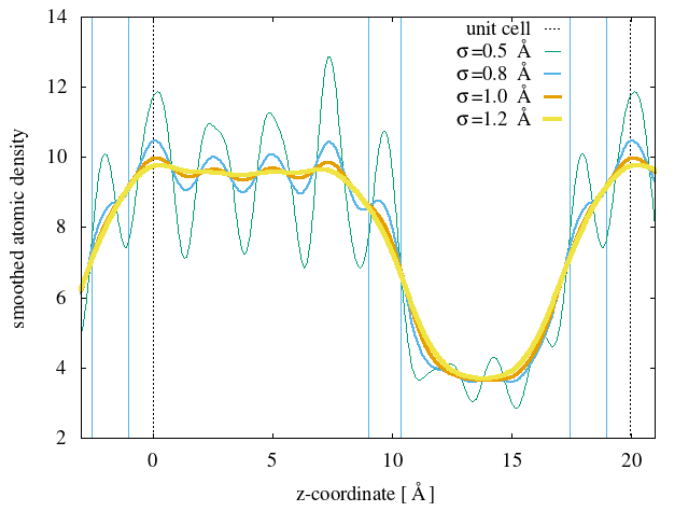
Figure 2. Planar average atomic density along the z direction (perpendicular to lamella surfaces) for the model shown in Figure 1. The various curves have been obtained by making different choices for the width σ for the Gaussian function representing each atom. The region considered ”surface” in the following is delimited by blue vertical lines. Dotted lines are the boundaries of the periodic